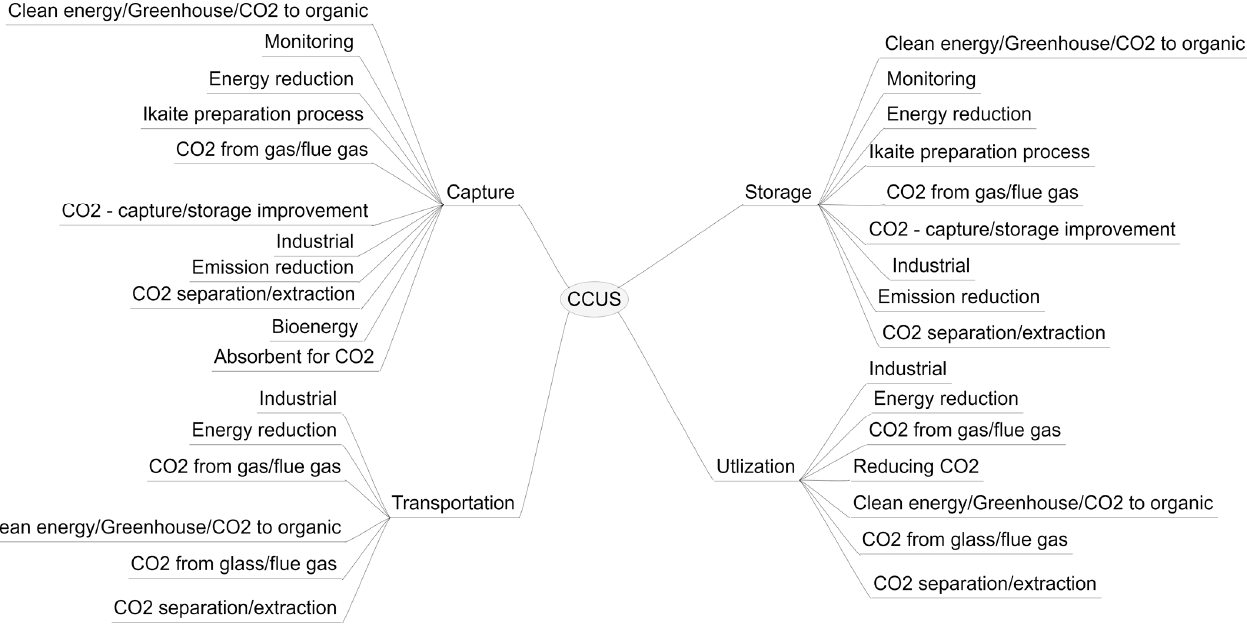
Figure 3. Schema (2) CCUS secondary classification.